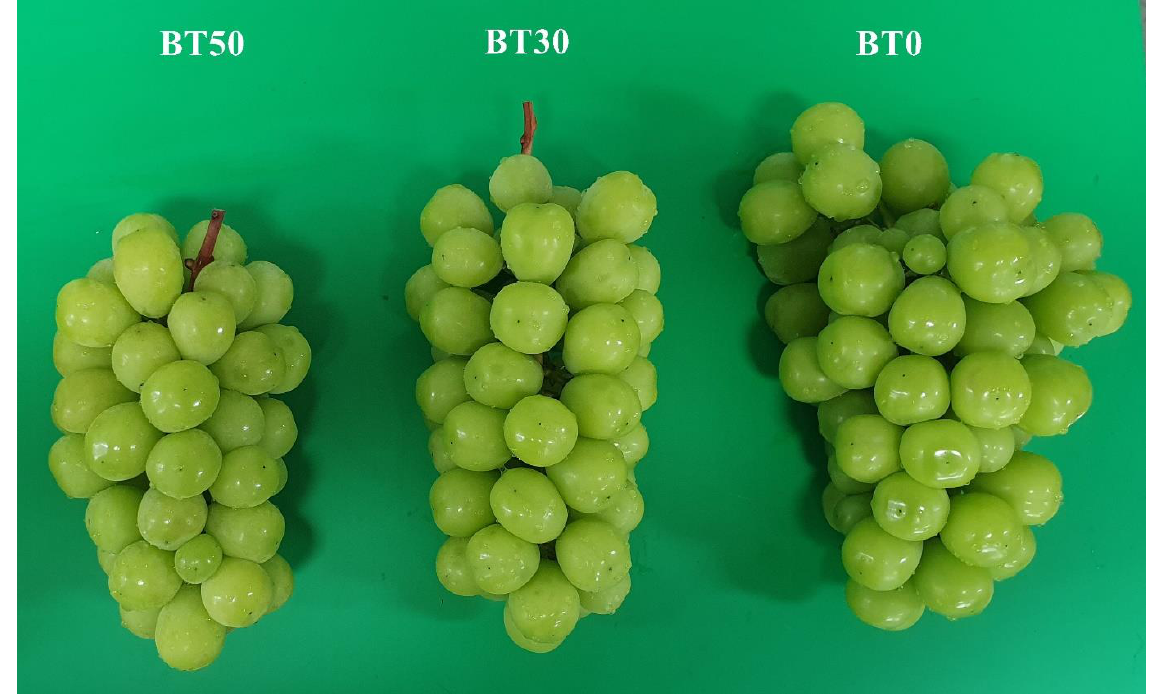
Figure 1. Effects of berry thinning on visual appearances of Shine Muscat grapes: BT0, BT30, and BT50 indicate the level of berry thinning in terms of percentage. Table 1. Effects of berry thinning on the skin color indices of Shine Muscat